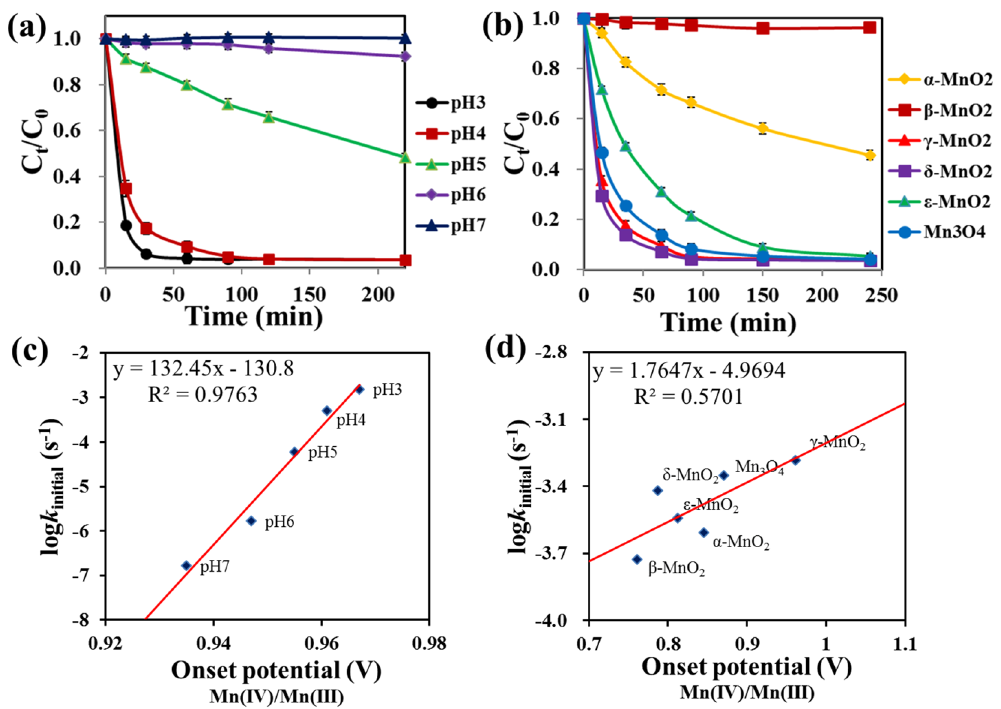
Figure 7. E2 removal in solutions ( a ) containing γ -MnO 2 under different pH, ( b ) containing different MnO x at pH 4.0. Reaction conditions: initial E2 concentration 10 μ M, MnO x dosage 1.0 mM. Error bar represents standard deviations (n = 3). The correlation between log k initial of E2 removal and the onset potential of Mn(IV)/ Mn(III) for ( c ) γ -MnO 2 at different pH, and ( d ) different MnO x at pH